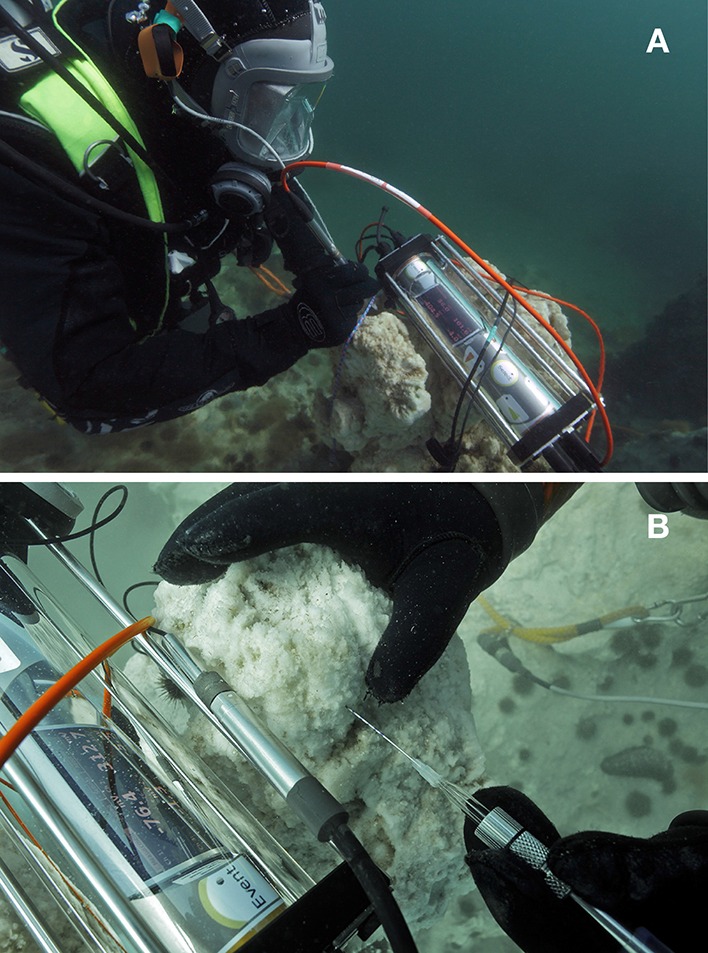
Ikaite columns. (A) Diver performing underwater microprofile pH measurements in the upper photic part of the column with its apex situated at a depth of 7 m below mean sea level. (B) Close-up photo showing diver-operated measurements with a needle O2 sensor connected to an underwater microsensor meter. The sensor was carefully inserted into the porous ikaite matrix by the diver using markings on the needle sensor as indicators of measuring depth.